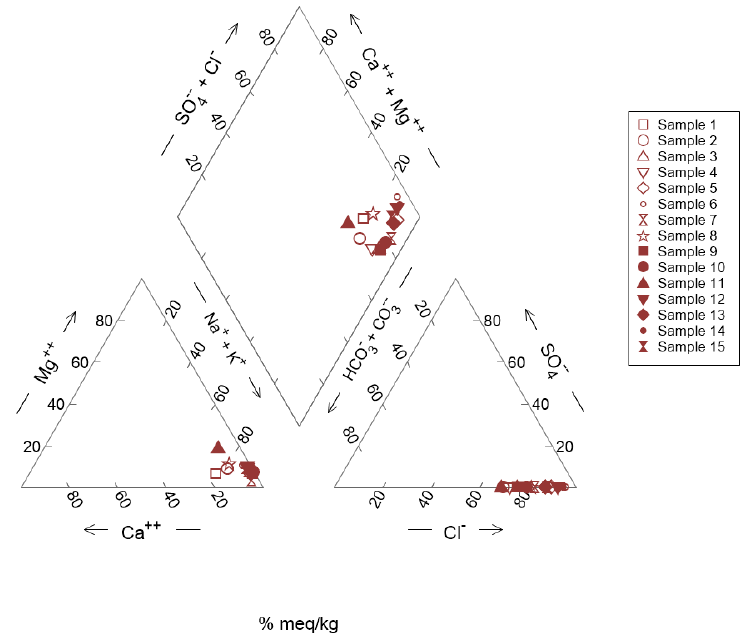
Figure 3. Piper trilinear diagram of the major ions representing hydrogeochemical facies.